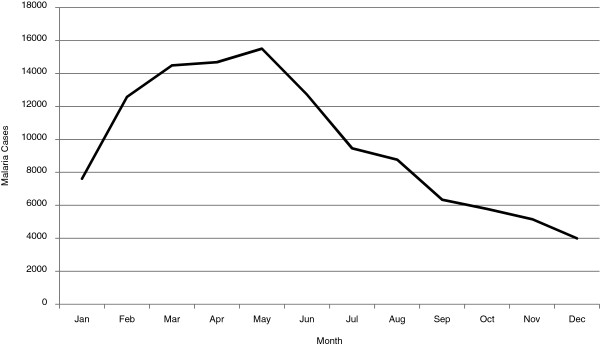
Distribution of malaria cases by month, Colombia, 2010.